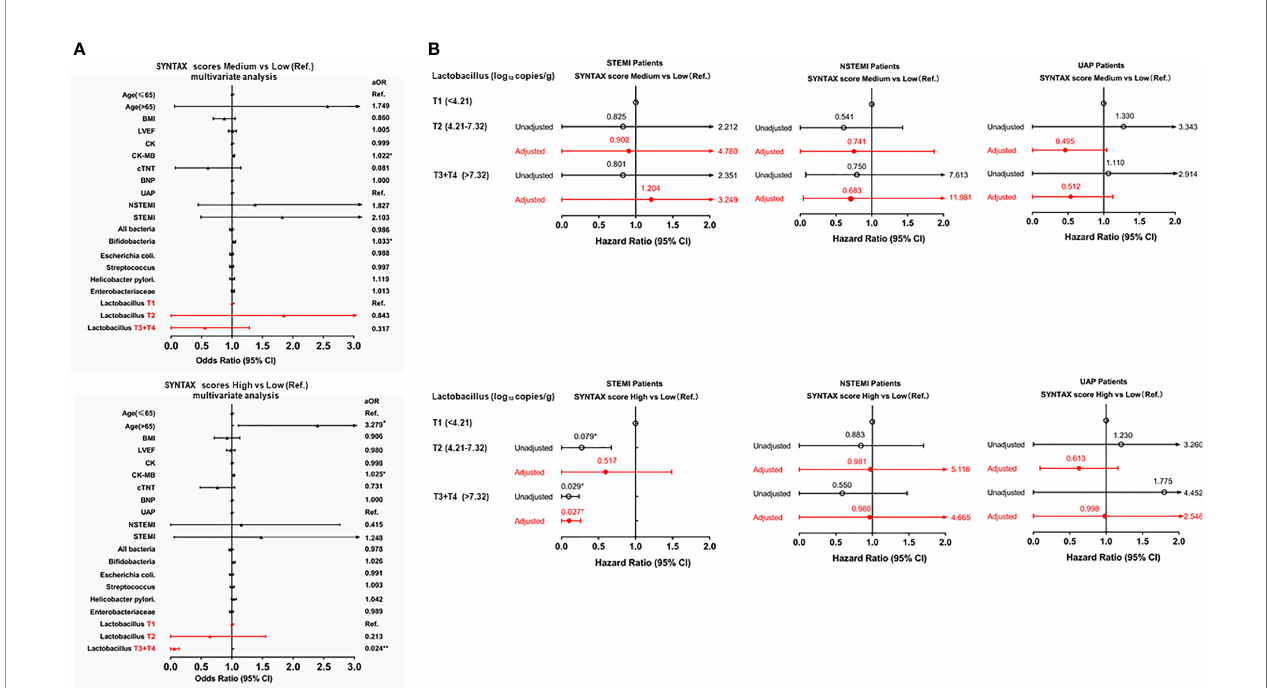
FIGURE 2 | Forest plot to show aORs and 95% CIs for the risks of a high SYNTAX score. (A) upper panel (ACS patients), medium vs low (reference); lower panel , high vs low (reference). (B) upper panel (STEMI, NSTEMI, and UAP subgroups), medium vs low (reference); lower panel , high vs low (reference). * p < 0.05; ** p <